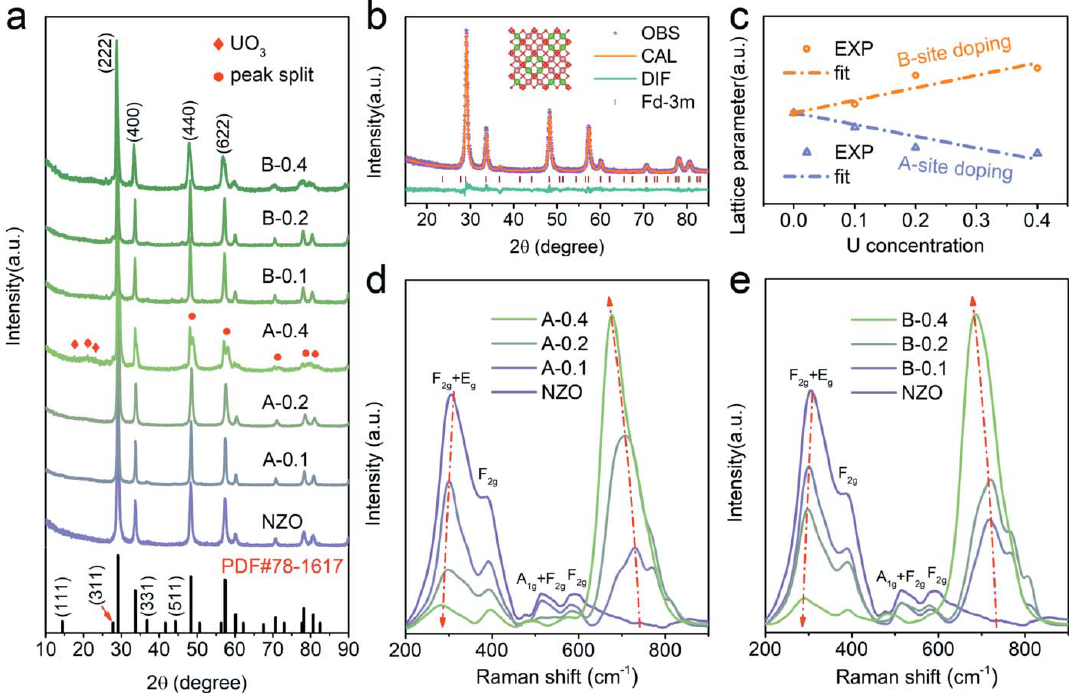
Figure 1 Structural characterization. ( a ) XRD profiles of Nd 2 Zr 2 O 7 , Nd 2– x U x Zr 2 O 7+ (cid:2) ( A (cid:5) 0.1, A (cid:5) 0.2, A (cid:5) 0.4) and Nd 2 Zr 2– y U y O 7+ (cid:2) ( B (cid:5) 0.1, B (cid:5) 0.2, B (cid:5) 0.4). ( b ) Rietveld refinement of XRD profile for Nd 2 Zr 2 O 7 (NZO). ( c ) Evolution of the fitted lattice parameters with the U concentrations. Raman spectra of ( d ) Nd 2– x U x Zr 2 O 7+ (cid:2) samples and ( e ) Nd 2 Zr 2– y U y O 7+ (cid:2)